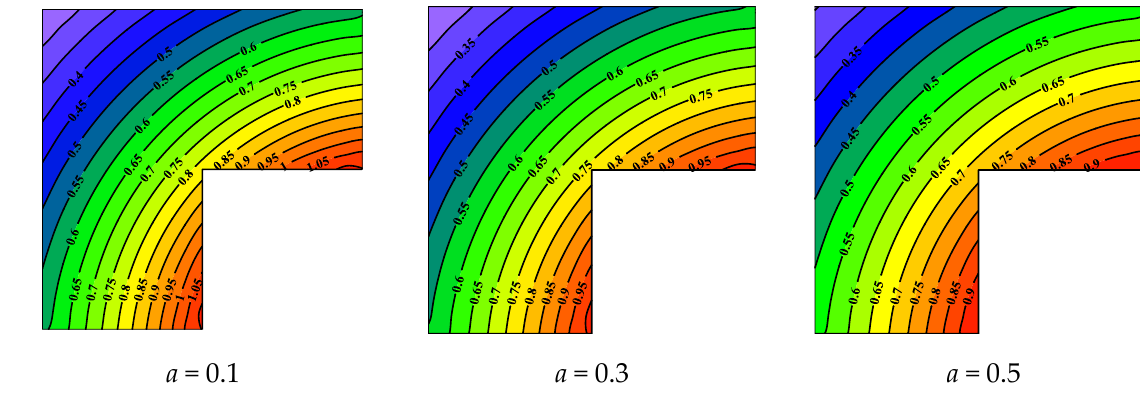
Figure 9. Contour map of temperature in the calculation domain, when a = 0.1, 0.3, 0.5. Finally, when the number of local domain nodes is fixed at 15, the convergence rate is given in Figure 10, where N a is the total number of nodes. From the numerical results in Figure 10, we can see that the maximum absolute error defined in Equation (31) obtained from the LMFS convergences after N a = 300. As the number of nodes increases after N a = 300, the maximum absolute error increases; however, the maximum absolute error still retains a high accuracy.